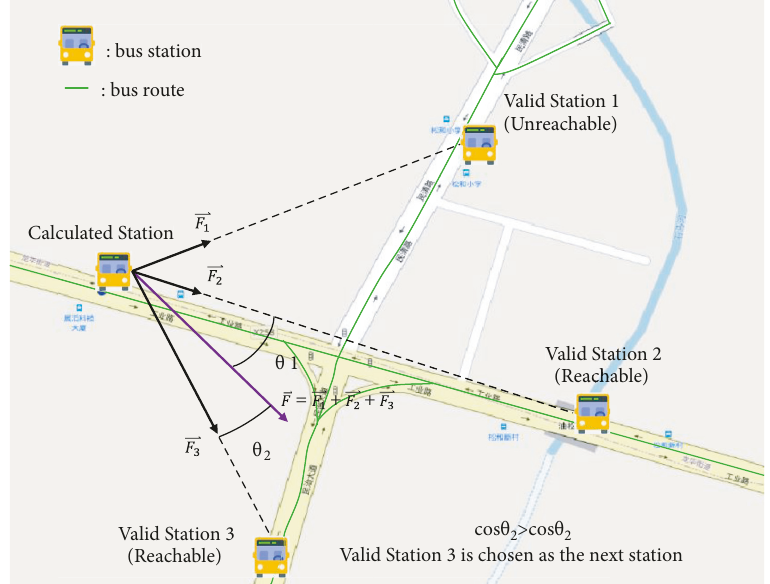
Figure 3: Station selection in pseudo force